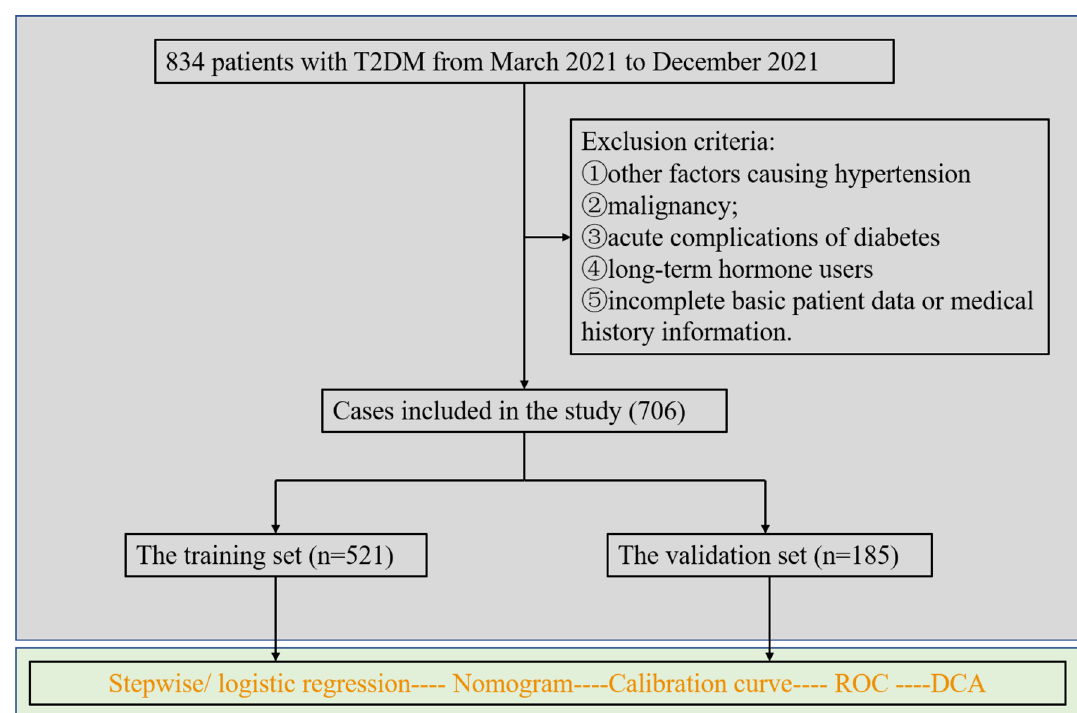
Figure 1. Flowchart of study